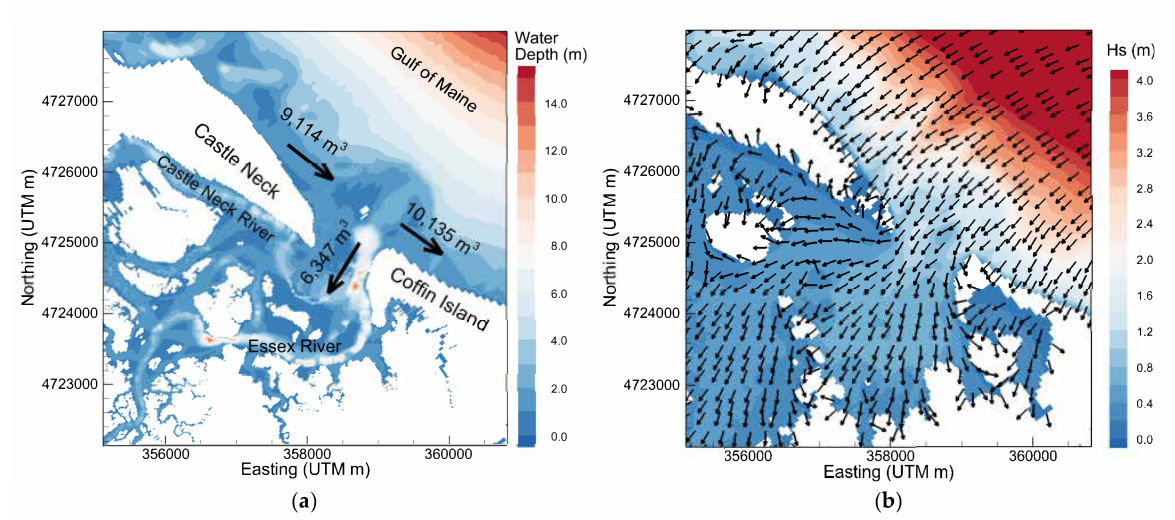
Figure 12. Results of Delft3D and SWAN modeling of a moderate magnitude extratropical northeast storm showing ( a ) cumulative sand transport in the vicinity of Essex Inlet and ( b ) significant wave heights (color) and wave energy transport direction (vectors) during maximum storm